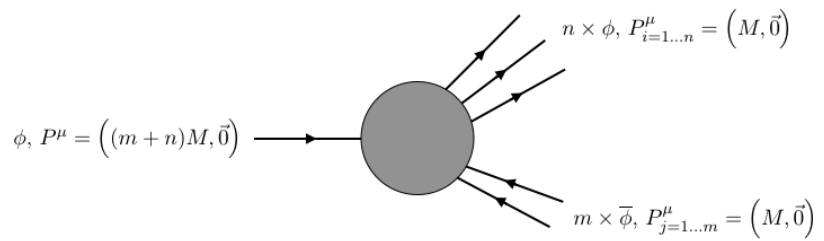
Figure 2 . Kinematic setup (particles/anti-particles are represented using direct/reversed